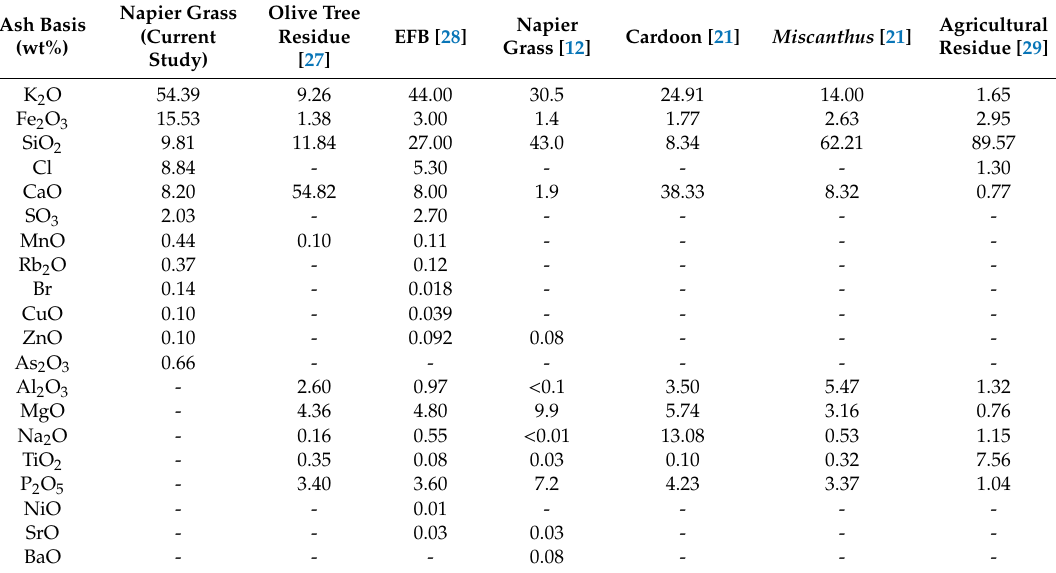
Table 3. Inorganic contents in ash of Napier grass and other types of biomass. Ash Basis